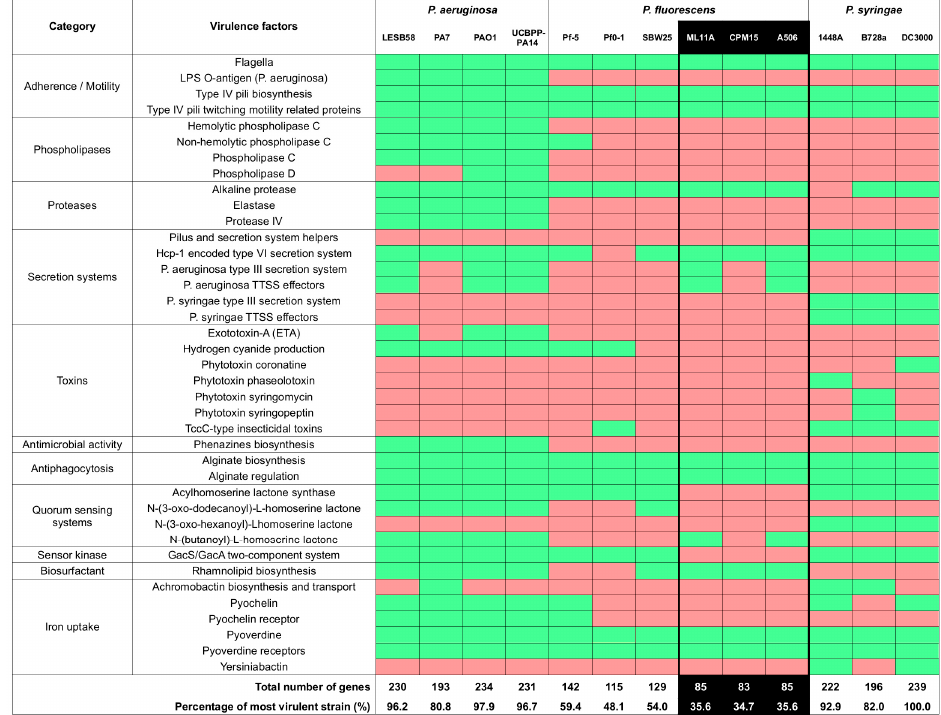
Figure 2. Candidate probiotic P. fluorescens ML11A is devoid of several virulence factor genes found in pathogenic Pseudomonas strains. Green: one or more genes that encode a given virulence factor (VF) are present. Red: no VF-encoding gene found. Columns for candidate probiotic and conspecific non-antagonistic strains are highlighted in black.